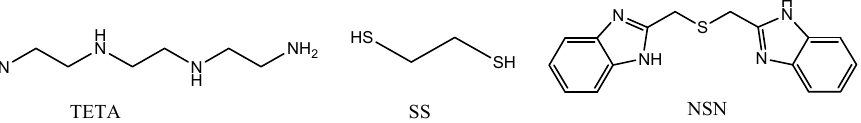
Figure 1. Chemical structures of extractants: Triethylenetetramine (TETA), Ethane-1,2-dithiol (SS) and Bis ((1 H -benzimidazol-2-yl)methyl)sulfide (NSN).